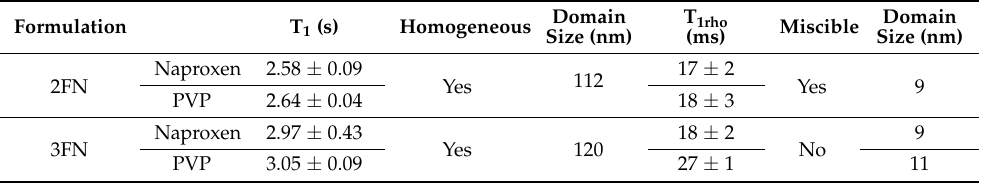
Table 2. Molecular homogeneity between naproxen and PVP in the 2FN and 3FN ASDs from ssNMR